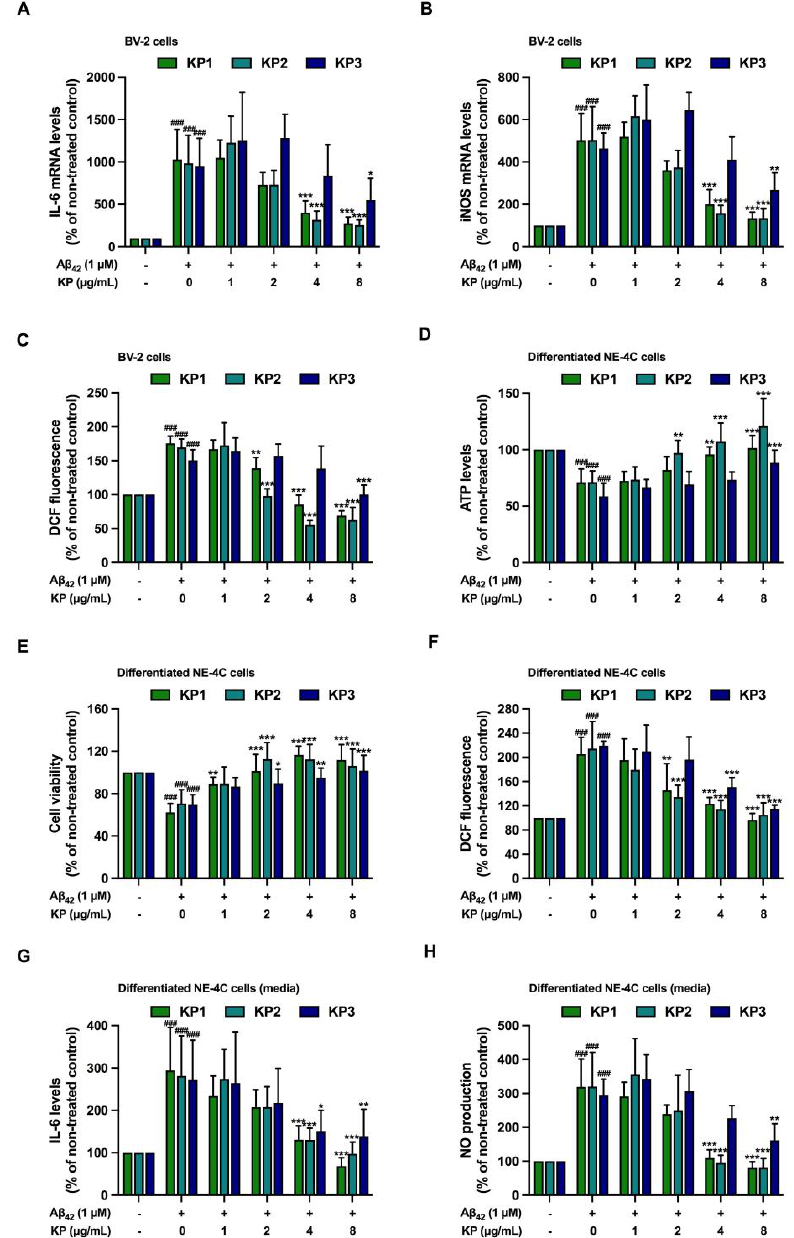
Figure 5. Anti-inflammatory and antioxidant effects of five K. parviflora fractions on A β 42 -induced neurotoxicity in co-culture between differentiated NE-4C and BV-2 cells. ( A ) IL-6 mRNA levels of BV-2 cells, ( B ) iNOS mRNA levels of BV-2 cells, ( C ) DCF fluorescence of BV-2 cells, ( D ) ATP levels of differentiated NE-4C, ( E ) cell viability of differentiated NE-4C, ( F ) DCF fluorescence of differentiated NE-4C, ( G ) IL-6 levels in culture media, and ( H ) NO production in the culture media. Values are mean ± SD of three independent experiments. The ### shows significant difference between the control and cells exposed to A β 42 peptides without KP extract at p < 0.001 using one-way ANOVA followed by Tukey’s test. The * shows significant difference between cells exposed to A β 42 peptides without KP extract compared to cells exposed to A β 42 peptides and various concentrations of KP extract (1–8 µ g/mL) using one-way ANOVA followed by Tukey’s test. *, p < 0.05, **, p < 0.01, ***, p <